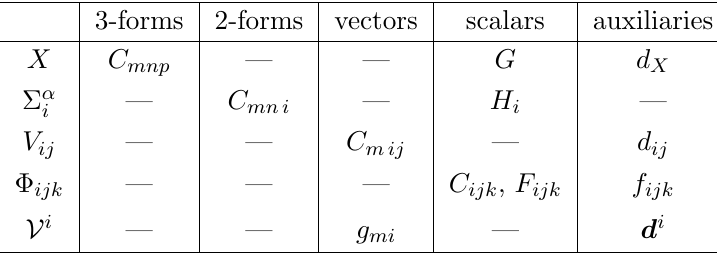
Table 1 . Bosonic (cid:12)eld content of the Chern-Simons prepotentials. We list the bosonic (cid:12)eld content of the gauged Chern-Simons super(cid:12)eld hierarchy. The bosons G , H i , and seven of the F ijk can all be removed by a choice of Wess-Zumino gauge (cf. section